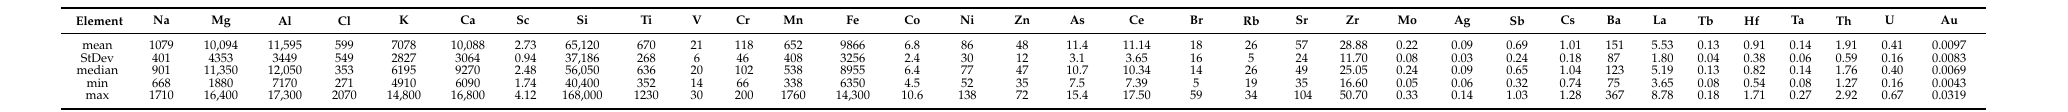
Table 2. The concentrations of trace elements (in µ g g − 1 ) in 10 moss samples collected only from the area of Skouries and determined by means of neutron activation analysis